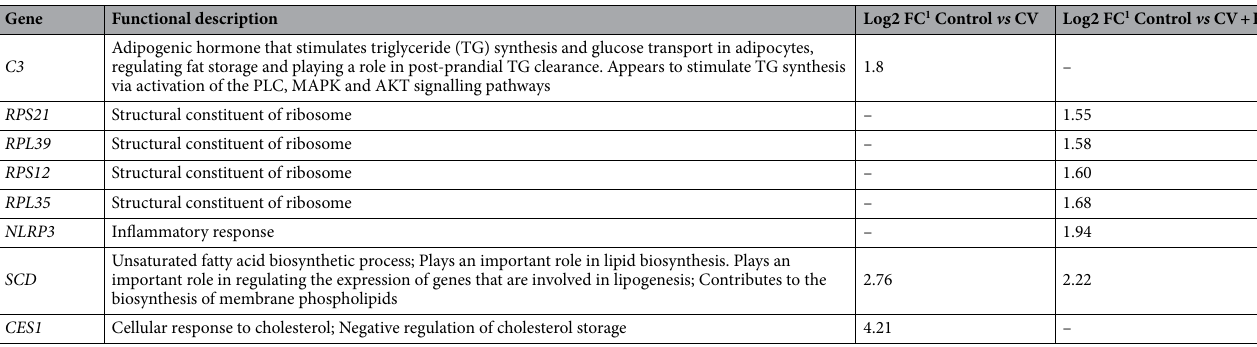
Table 1. Identified DEGs by functional analysis with Cytoscape software for comparisons Control vs CV and Control vs CV + R, its respective functional description and Log2 FC. 1 Log2 FC > 1—upregulated in Control group; Log2 FC < 1—downregulated in Control group.